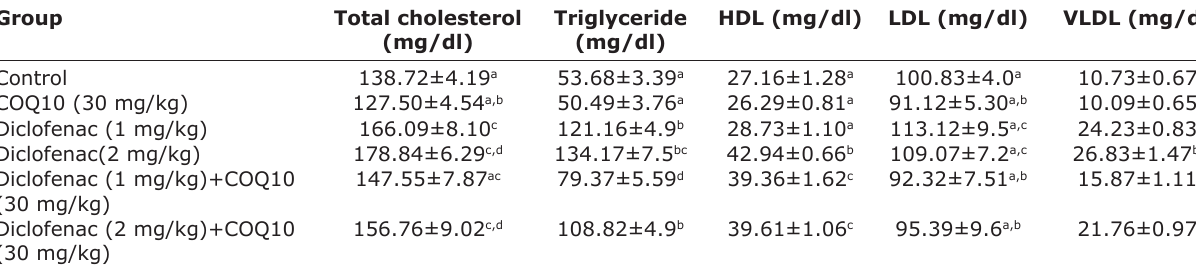
Table-2: Effect of COQ10 and diclofenac on lipid profile (n=8). Group